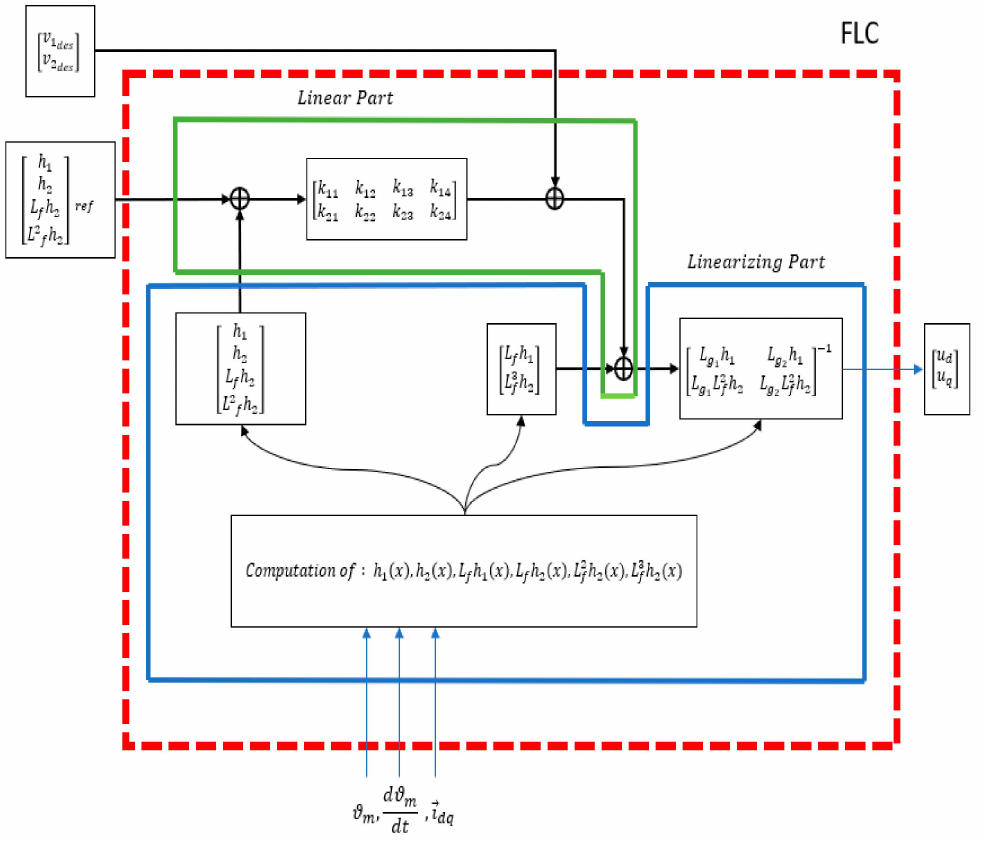
Figure 6. Schematic representation of the feedback linearization control (FLC) structure.